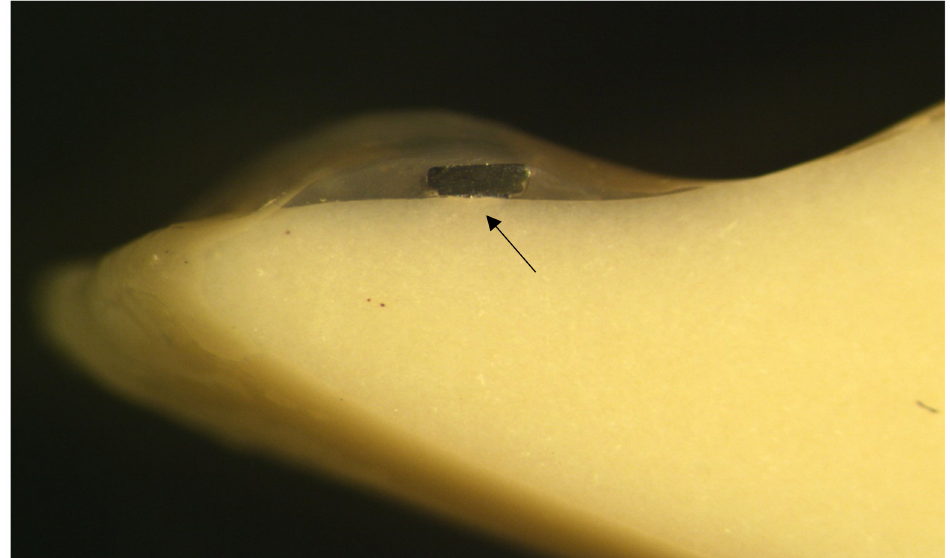
Figure 4. Photograph of the longitudinal section of a Frasaco tooth Straight 8 and flowable resin composite cover. The arrow points the place of the